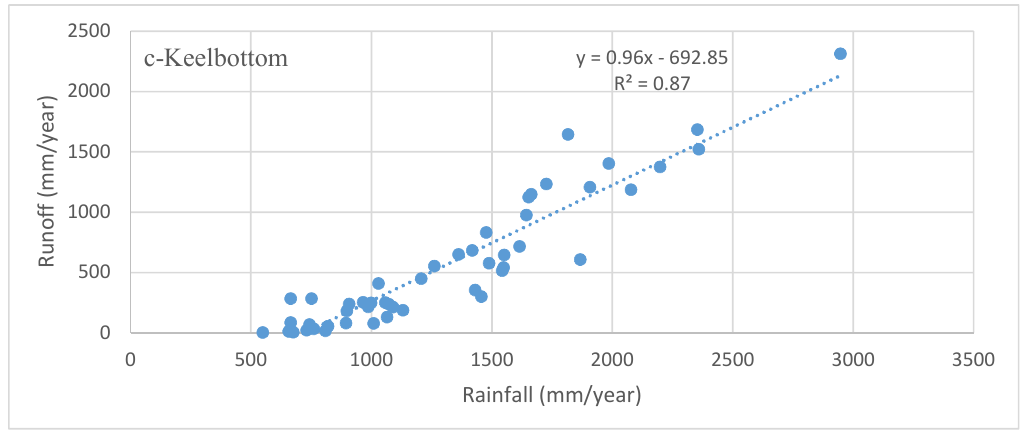
y = 0.96x - 692.85 y = 0.96x - 692.85 R² = 0.87 R² = 0.87